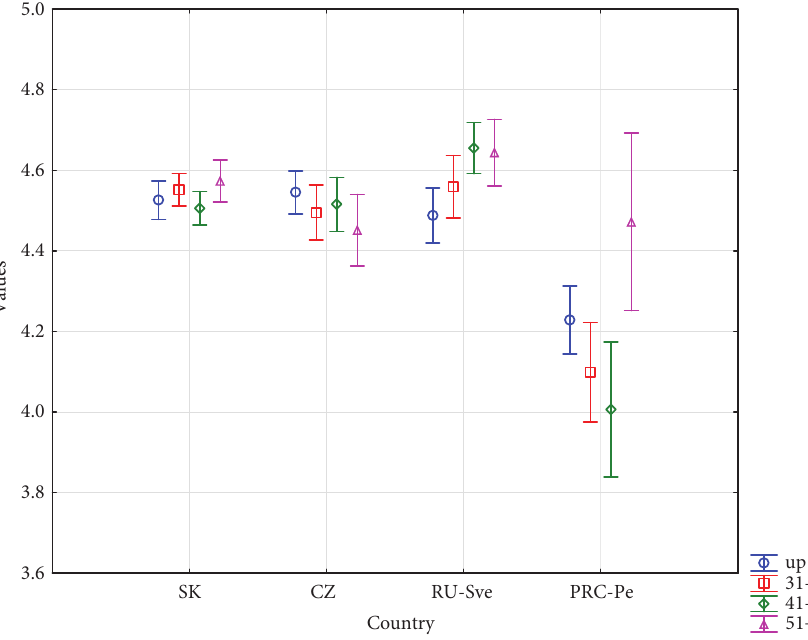
Figure 3. “Atmosphere in the workplace” interactions and age groups